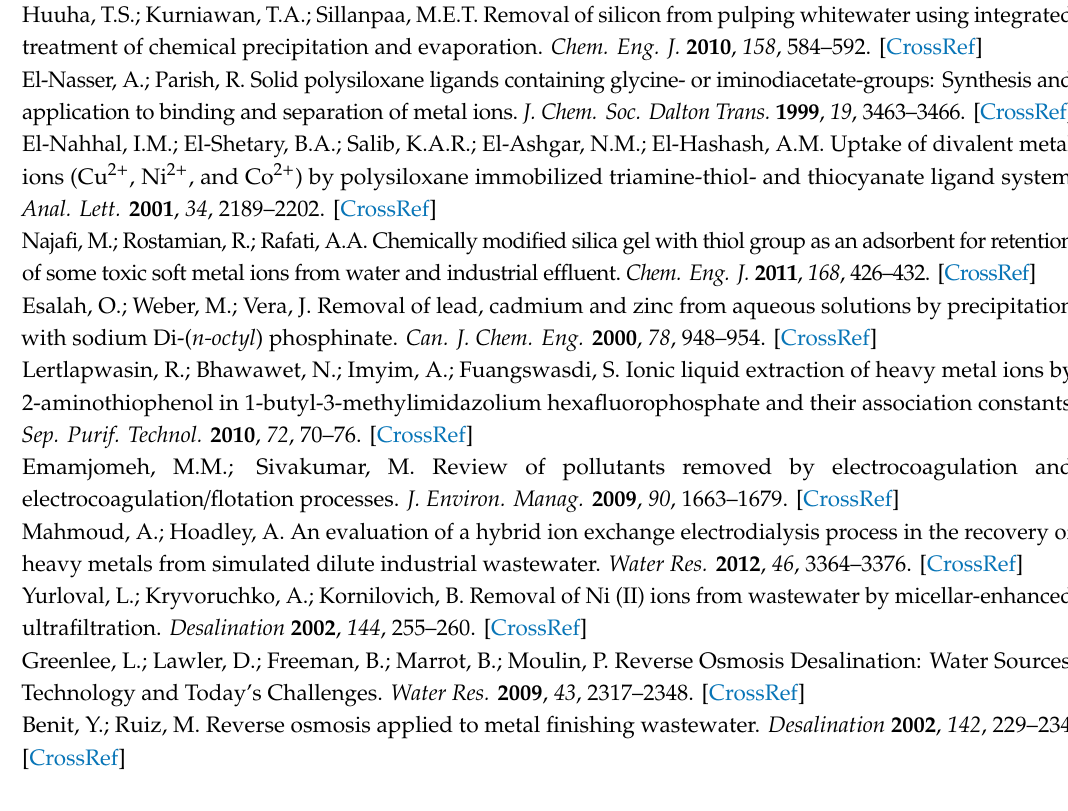
Figure S1. 1 H-nuclear magnetic resonance (NMR) absorption spectrum of the Schi ff base. Figure S2. 13 C NMR spectra of the Schi ff base. Figure S3. Thermogravimetric (TGA) curves of the Schi ff